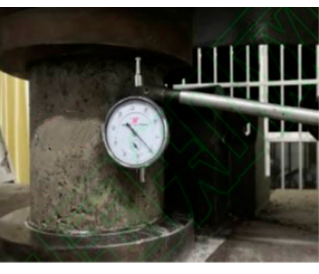
Figure 6. Mechanical properties test.